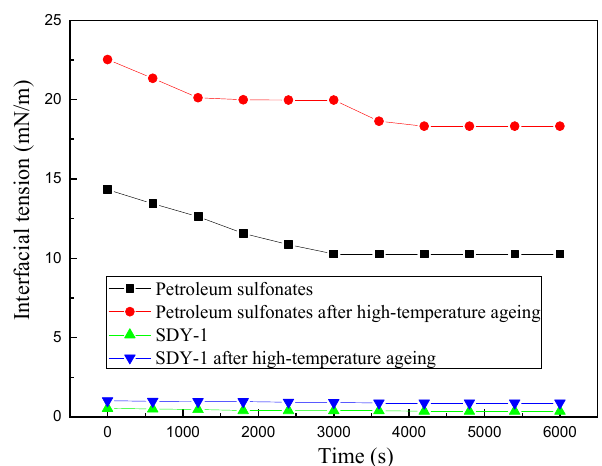
Figure9. Thevariationsininterfacialtensionofthesurfactantsbeforeandafterhigh-temperatureageing. Figure 9. The variations in interfacial tension of the surfactants before and after high-temperature ageing.